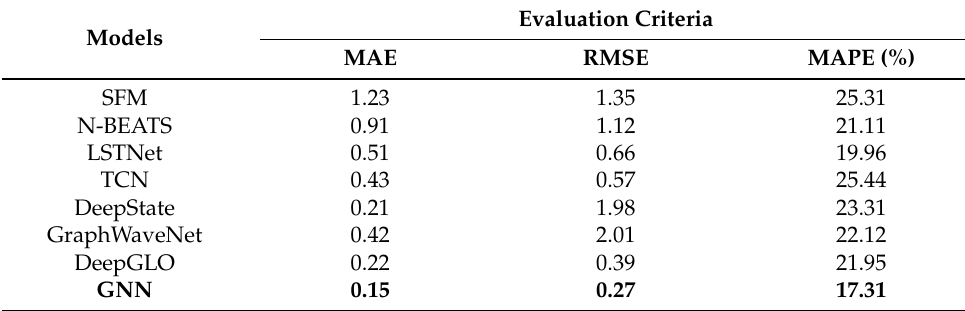
Table 3. Model experiments in MIT-BIH arrhythmia